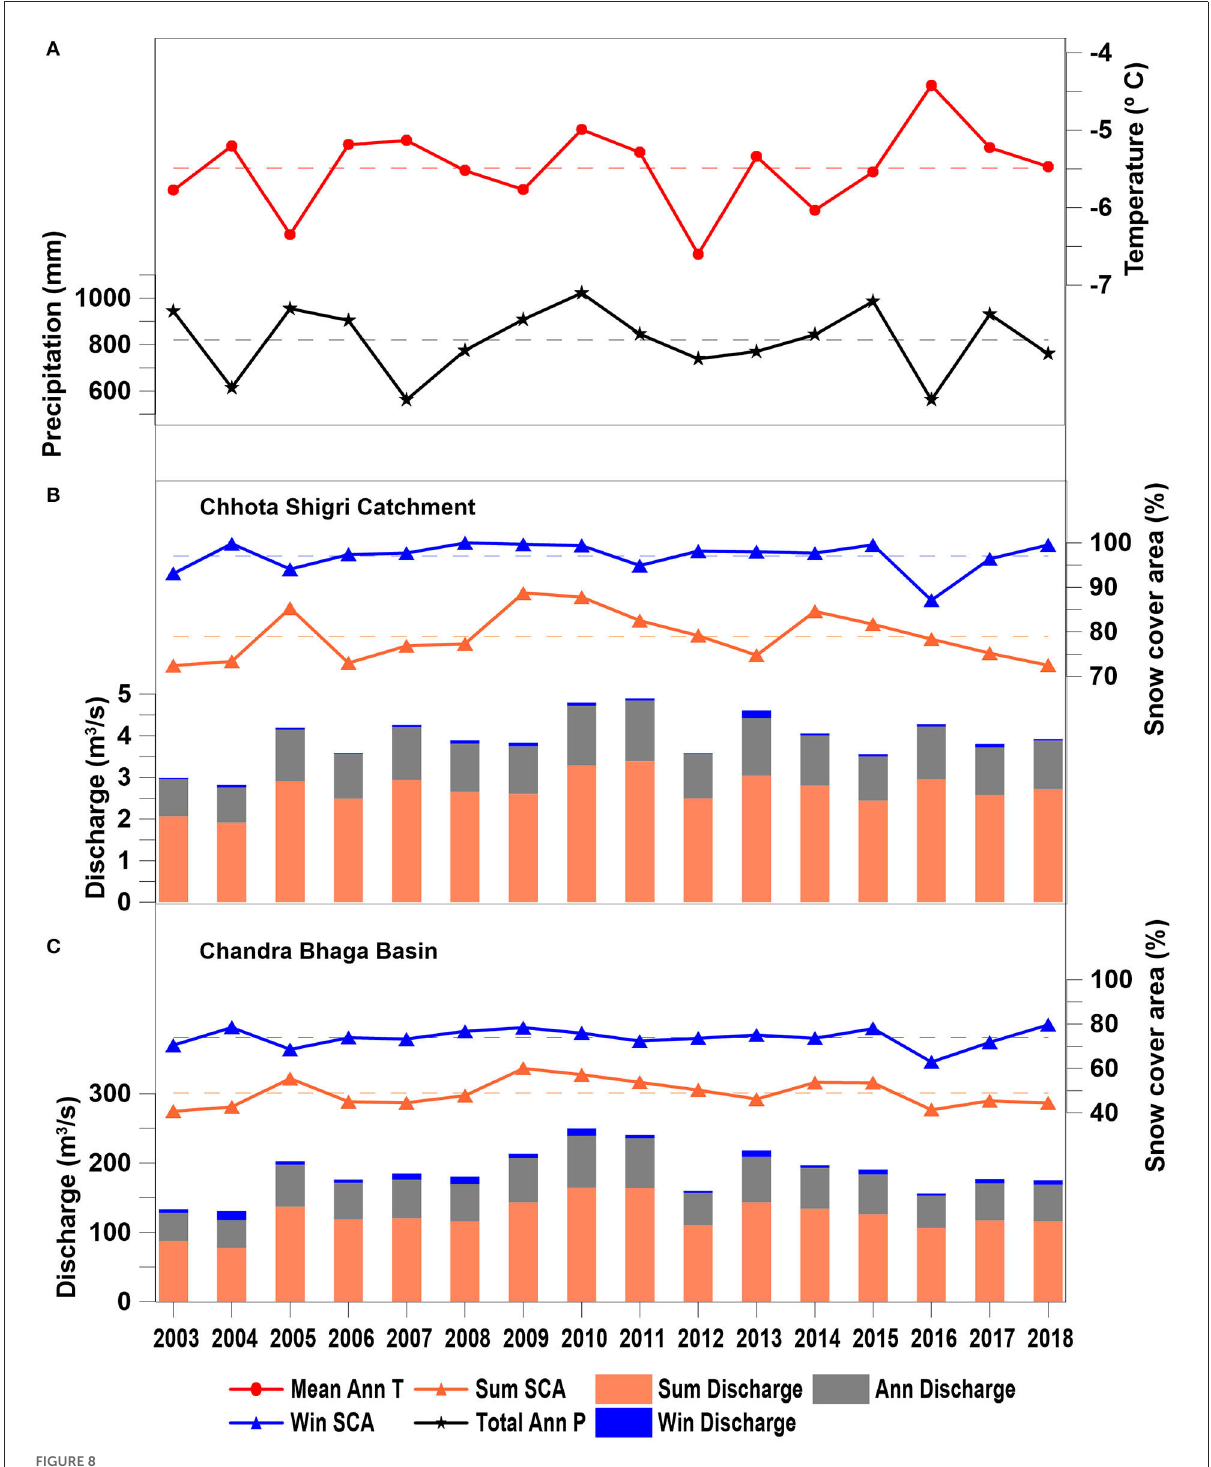
FIGURE8 Seasonal (summer in orange and winter in blue) and annual (gray) discharge patterns over 2003–2018 with total precipitation (black) and mean temperature (red) patterns for Chhota Shigri Catchment (B) and Chandra-Bhaga Basin (C) . The summer season is from May to September and the winter season is from October to December and January to April. Total precipitation and mean temperature patterns plotted here represent the data from the ERA5 grid point location (A) . Dashed lines are showing the average values over 2003–2018 of temperature (red), precipitation (black), winter SCA (blue), and summer SCA